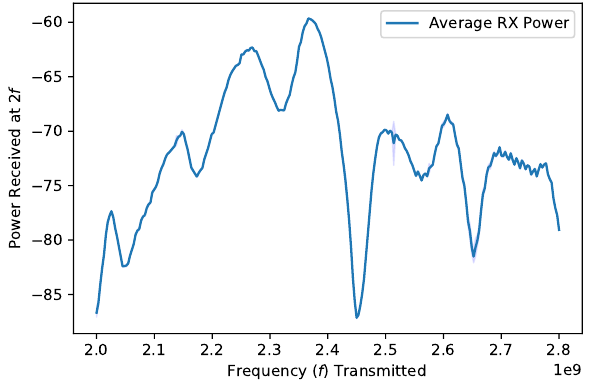
Figure 6. Harmonic response for a laptop over a range of 800 MHz. Frequencies were tested in steps of 3.2 MHz. The values in the plot are an average of 5